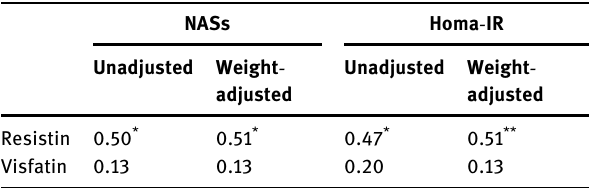
Table 3: Correlation coe ffi cients for serum adipokine levels with NASs and Homa - IR in rats fed high - fat diet